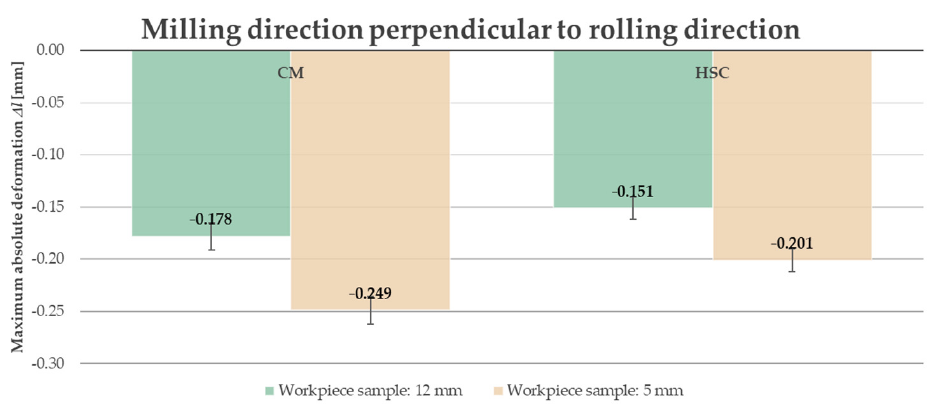
Figure 15. Comparison of the maximum absolute deformations ∆ l depending on the ratio of the milling direction to the rolling direction for the semi-finished product with a thickness of 5 mm.